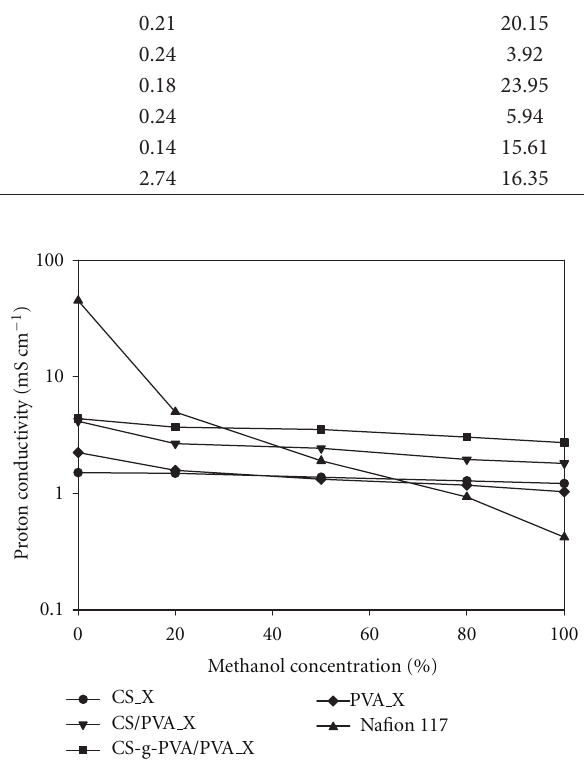
F 4: Proton conductivities of crosslinked membranes at various concentrations of methanol